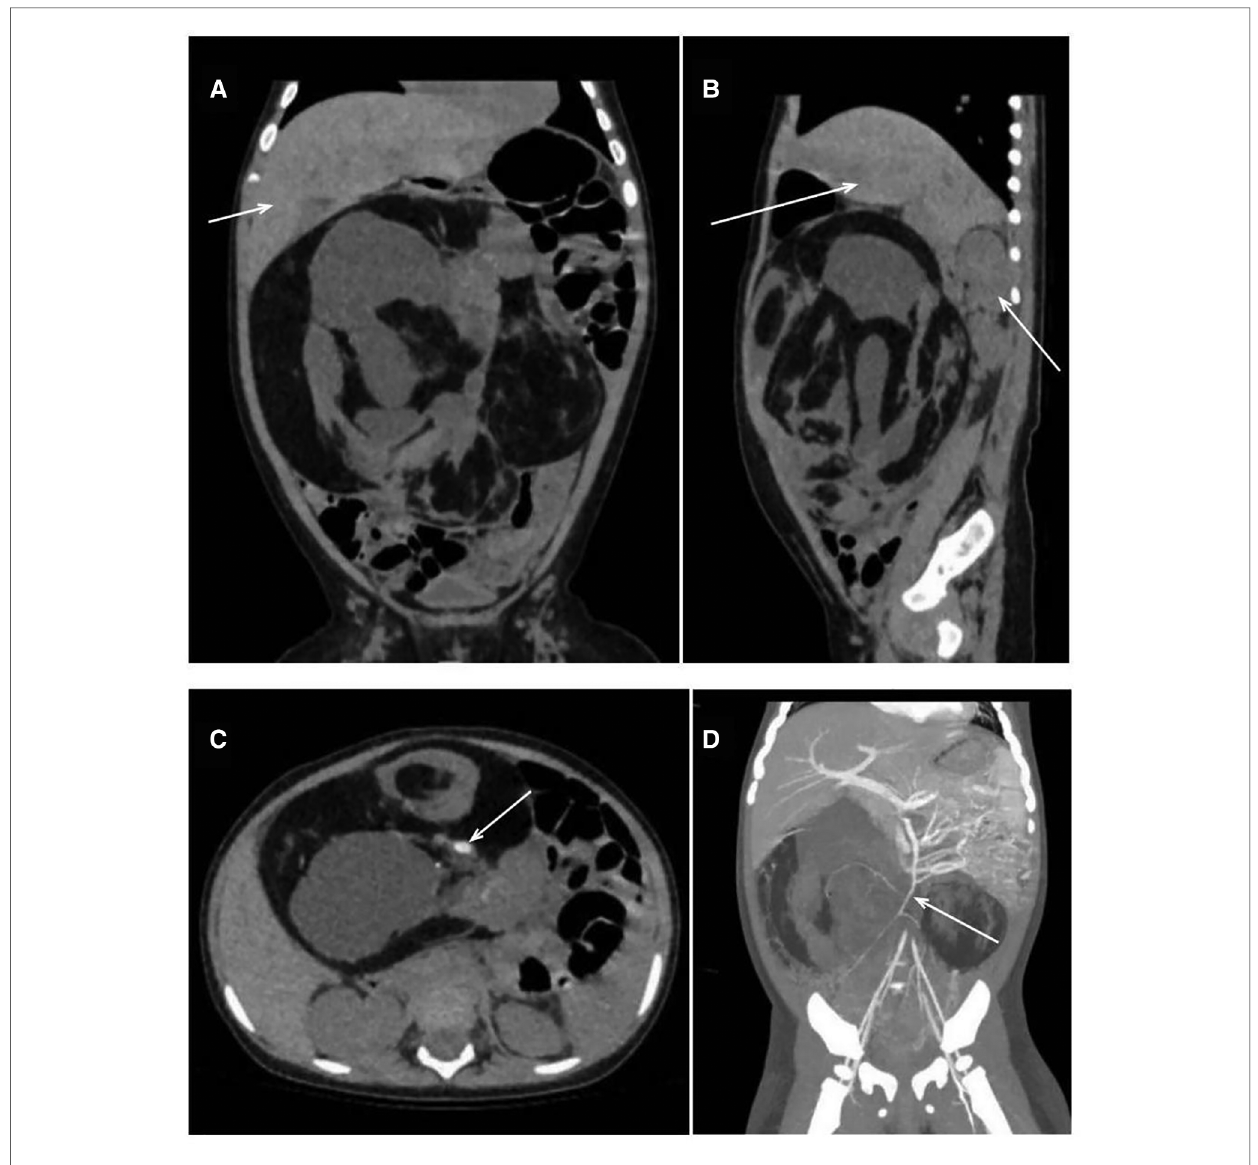
FIGURE 1 CT obtained at this hospital. CT images ( A , B ), obtained before the administration of intravenous contrast material, show a multilobulated cystic mass compressing the liver and right kidney (arrows). The CT image ( C ) shows a mixed density of mass, including a calci fi ed shadow (arrow). The CT image obtained after the injection ( D ) con fi rms that the structure was supplied by the superior mesenteric artery (arrow). CT, computed